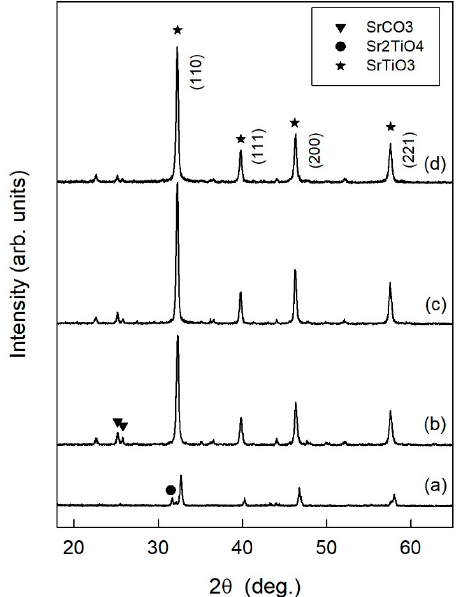
Fig. 2 XRD patterns of Rh-doped SrTiO 3 catalysts ( a ) SS-STO2Rh ( b ) HT-STO2Rh ( c ) MW-STO2Rh- A ( d ) MW-STO2Rh-T. ( d )